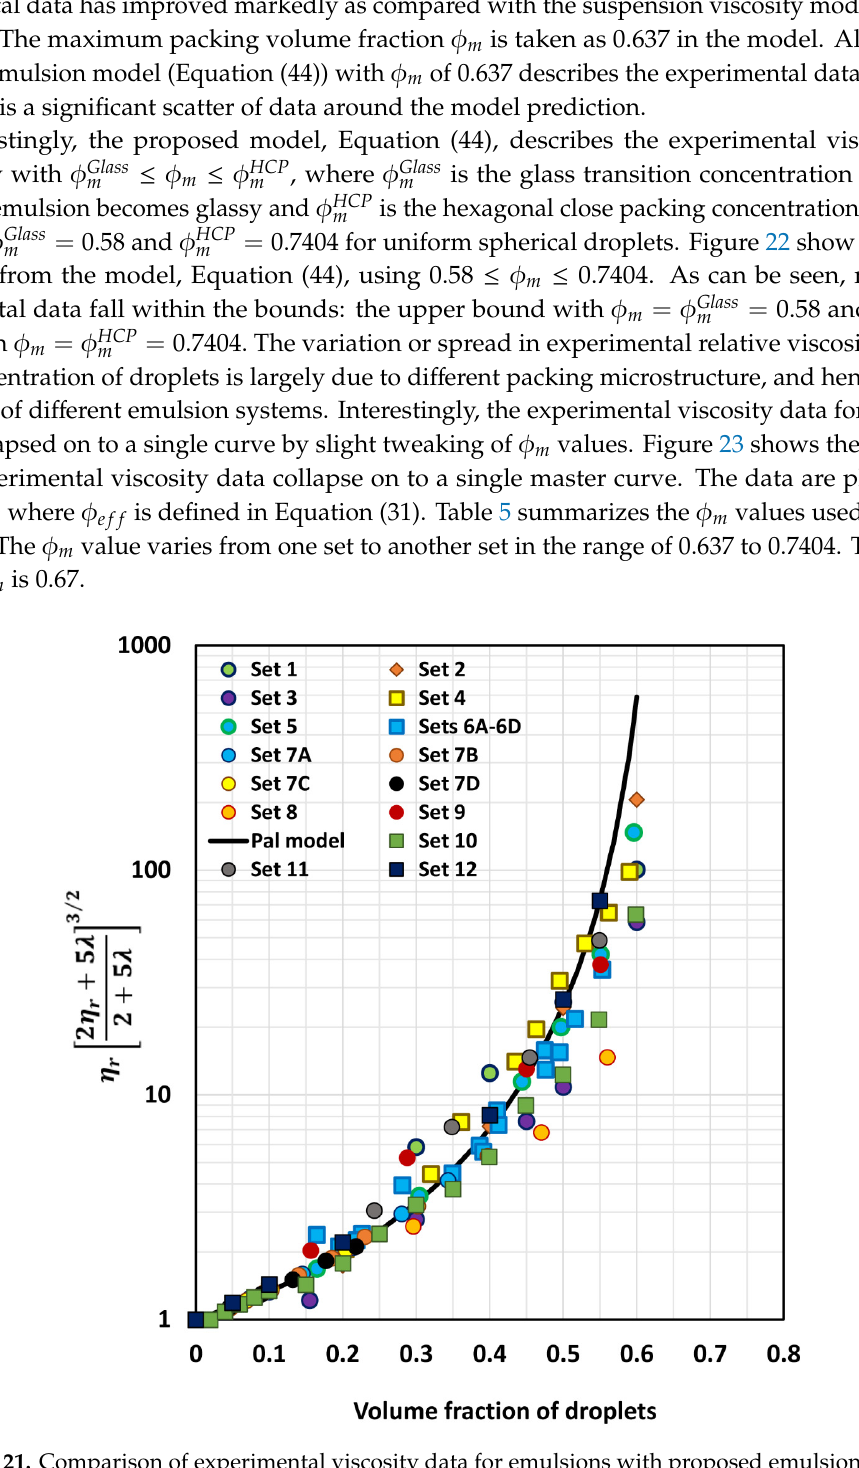
Figure 21. Comparison of experimental viscosity data for emulsions with proposed emulsion model (Equation (44) with φ m of 0.637).